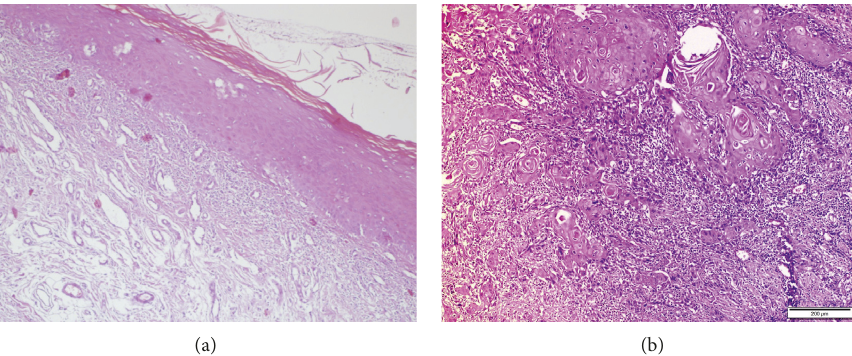
Figure 2: (a) H&E × 100: lichen planus with hyperkeratosis, parakeratosis, epidermal hyperplasia, eosinophilic colloid bodies (Civatte), and lymphocytic infiltration at superficial dermis. (b) H&E × 10: areas infiltrated with OSCC.